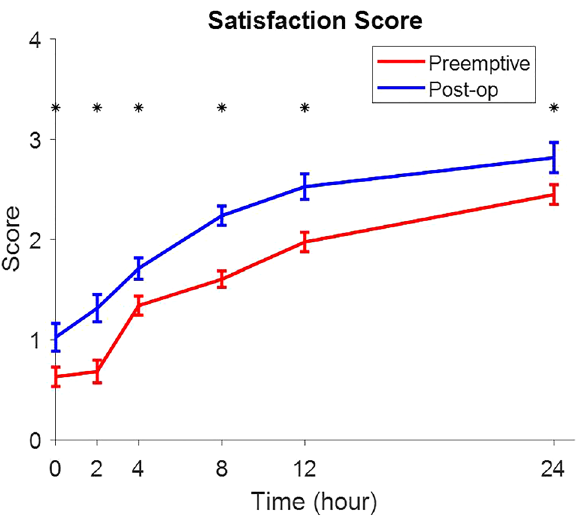
Figure 4. Patient satisfaction scores were significantly increased in both groups in all times (Fig.